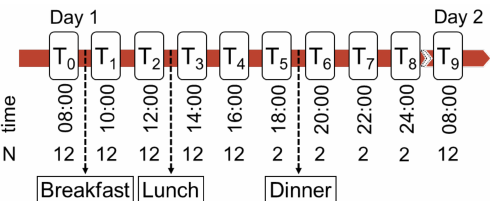
Figure 1. 24-h monitoring experiment, timeline of blood sampling. Sampling times (T0–T9), number of participants (N) and meals during the sampling procedure over 24 h on two subsequent